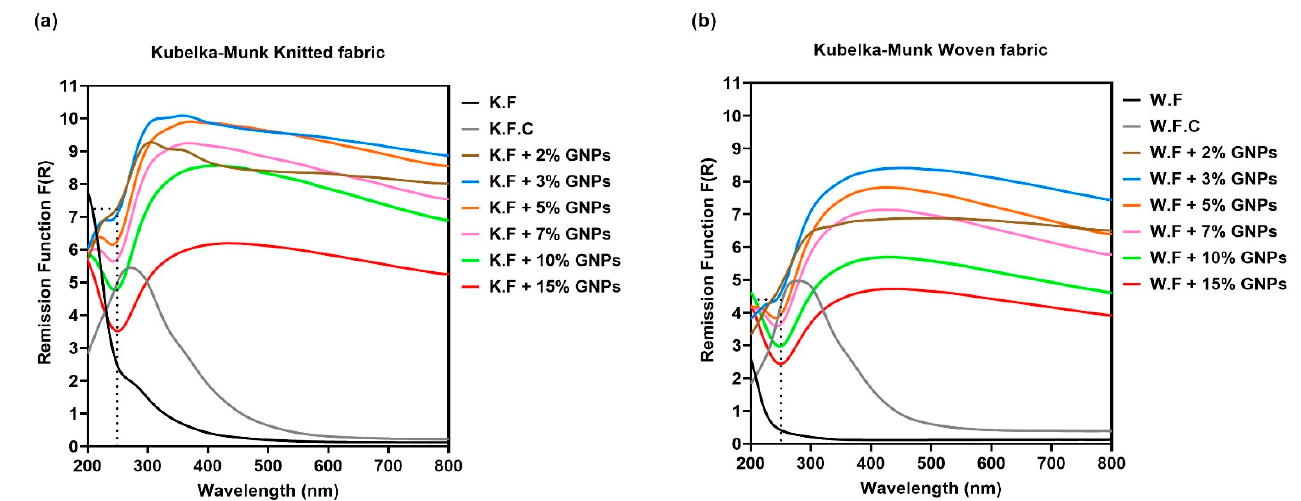
Figure 8. ( a ) GSDR spectra of non-functionalised and functionalised knitted fabrics with different GNPs %; ( b ) GSDR spectra of non-functionalised and functionalised woven fabrics with different GNPs %. The dotted line indicates the GNPs zone of absorption in the functionalised samples.